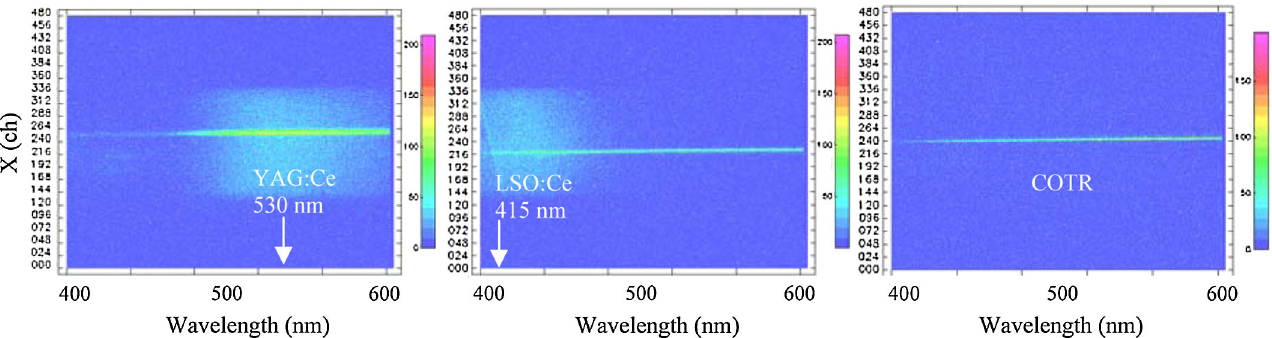
FIG. 11. (Color) Imaging spectrometer results with CCD camera readout in x - (cid:2) space for YAG:Ce plus an Al mirror (left), LSO:Ce plus an Al mirror (middle), and an Al mirror only (right). The localized x extent of the COTR streak in wavelength is evident in all three configurations.